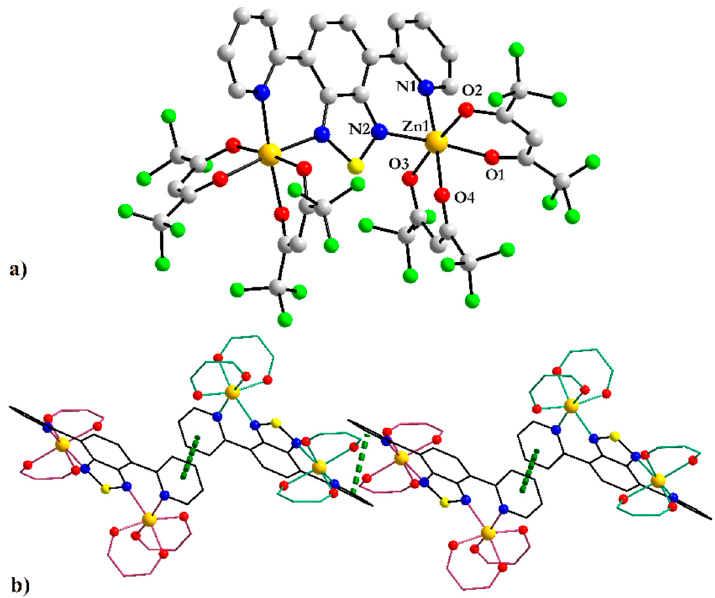
Figure 2. ( a ) Crystal structure of [Zn 2 (hfac) 4 (2-PyBTD)] ( 2 ) with a partial atom numbering scheme; ( b ) View of the packing diagram illustrating the opposite chirality of the metal centers from neighboring binuclear complexes (green— Λ configuration, violet— Δ configuration) (CF 3 groups have been omitted for clarity).